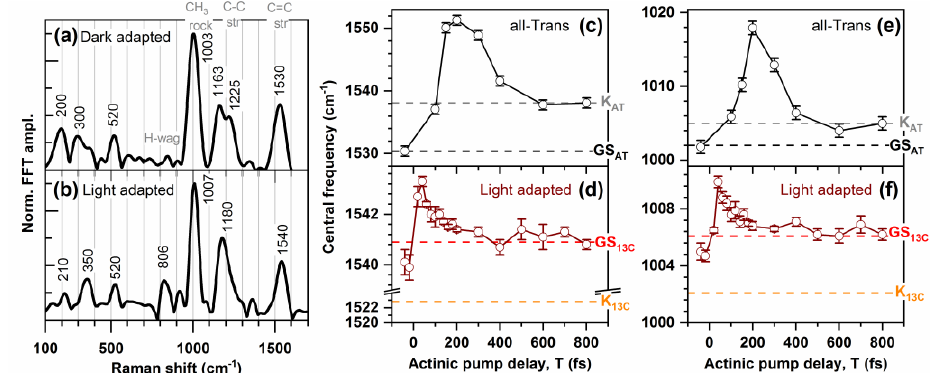
Fig. 2. The pure GS vibrational spectra of AT (a) and 13C (b) isomer. The excited state evolution of C=C stretching (c, d) and CH 3 rock modes (e, f) obtained for the pure AT isomer (c, e) and LA (d, f) form ASR. Centre frequencies of pure GS (AT and 13C), LA GS and pure K-photo intermediates (K AT and K 13C ) are shown by black, red, brown, grey and orange dotted lines respectively in each